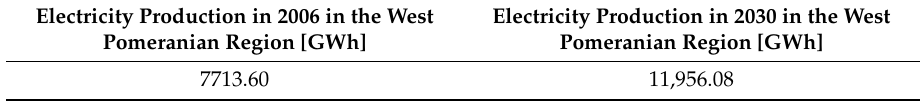
Table 12. Electricity production forecast in the West Pomeranian Region in 2030 according to scenario II. Electricity Production in 2006 in the